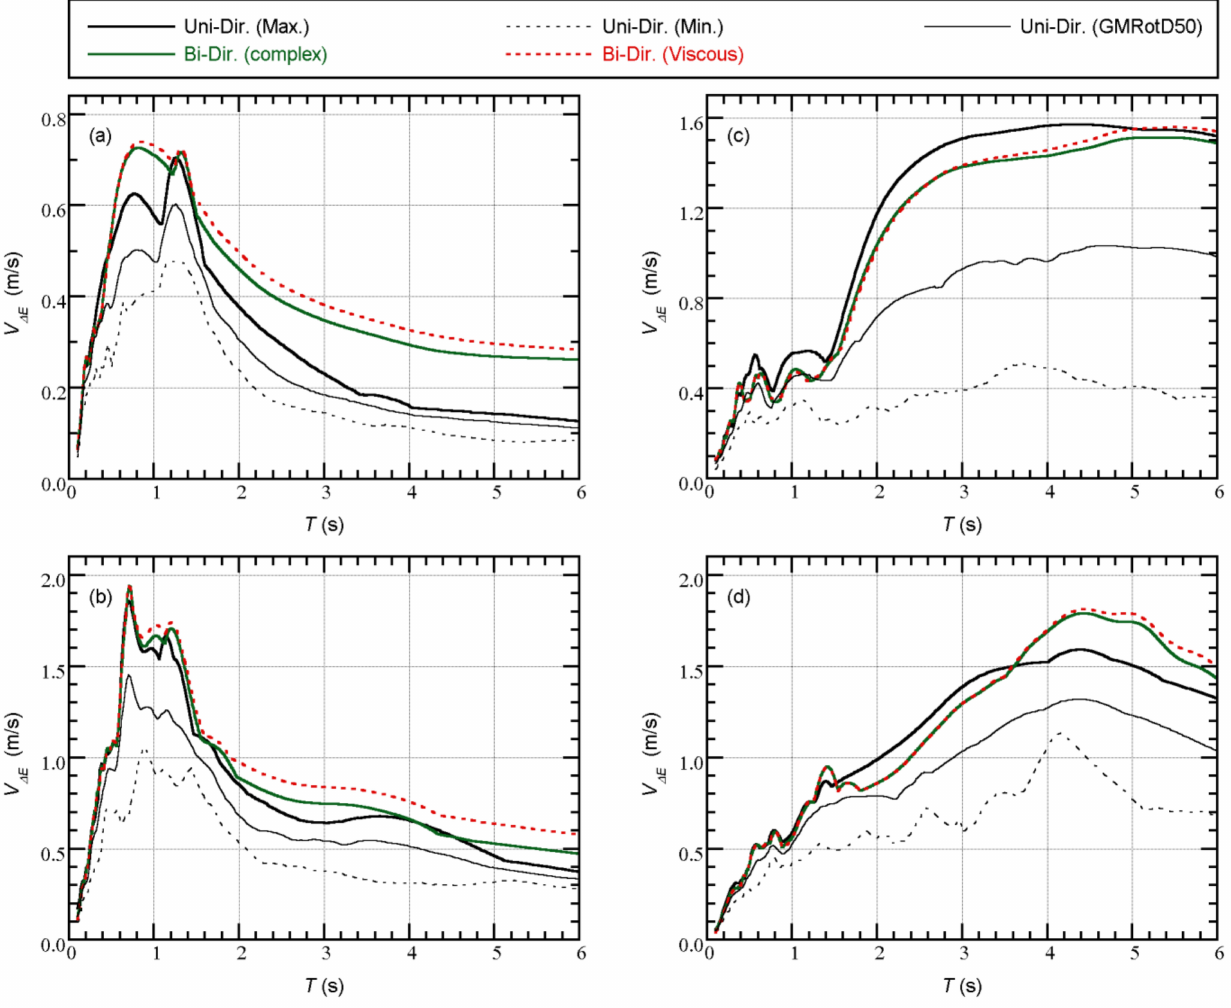
Figure A6. Comparisons of the unidirectional and bidirectional V ∆ E spectra for recorded ground motion datasets: ( a ) UTO0414; ( b ) UTO0416; ( c ) TCU; ( d )